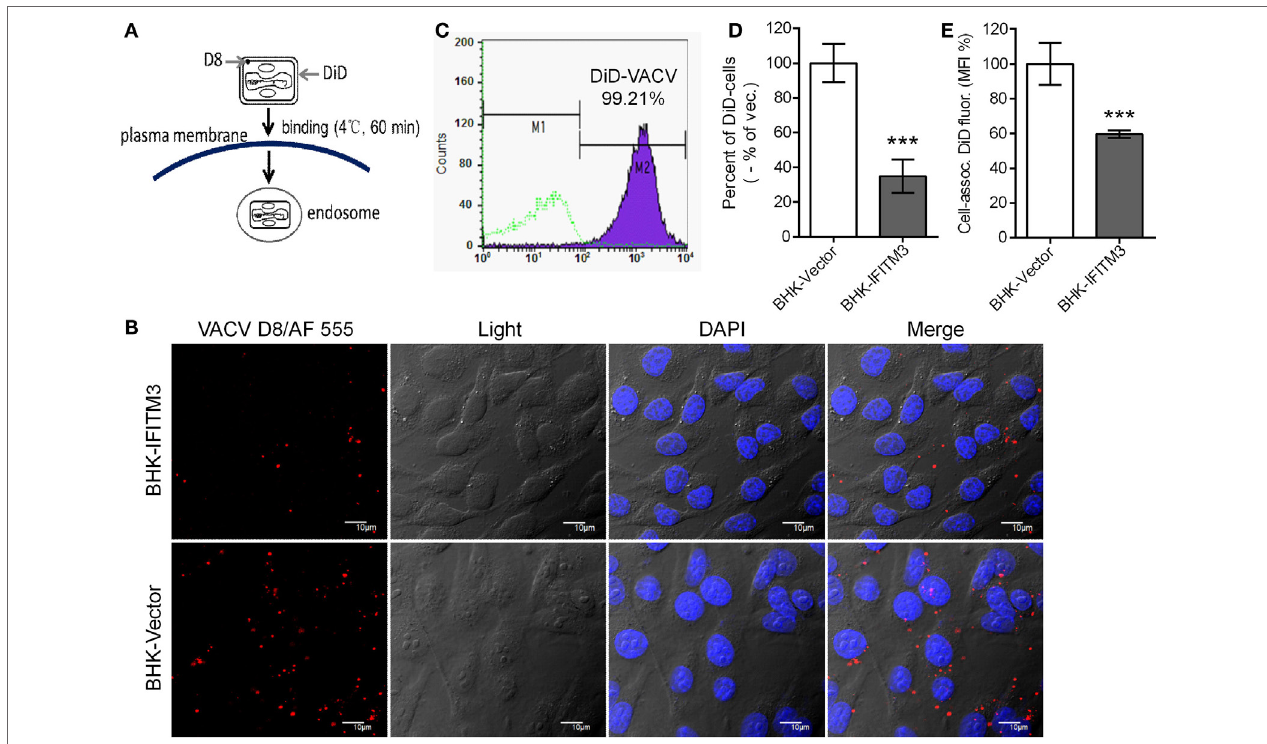
FigUre 6 | Interferon-inducible transmembrane protein 3 (IFITM3) overexpression disturbs vaccinia virus (VACV)-cell binding. (a) Schematic representation of virus attachment analysis by immunostaining of viral D8 protein or using fluorescent probe DiD-labeled virus. (B) Baby hamster kidney (BHK) cell lines were incubated with VACV Tian Tan (VTT) at 4°C for 1 h, followed by washing, fixation, immunostaining with anti-D8 antibody (red), staining for DNA (blue) and imaging by confocal laser scanning microscopy. (c) VTT particles were labeled with DiD and detected by flow cytometry. (D,e) BHK cell lines were incubated with DiD-labeled VTT at MOI of 5 for 1 h on ice, washed, digested and fixed, and DiD-positive cells (D) and DiD mean fluorescence intensities (e) were quantified by flow cytometry. Values (D,e) represent the mean ± SD of three independent experiments. ** P <